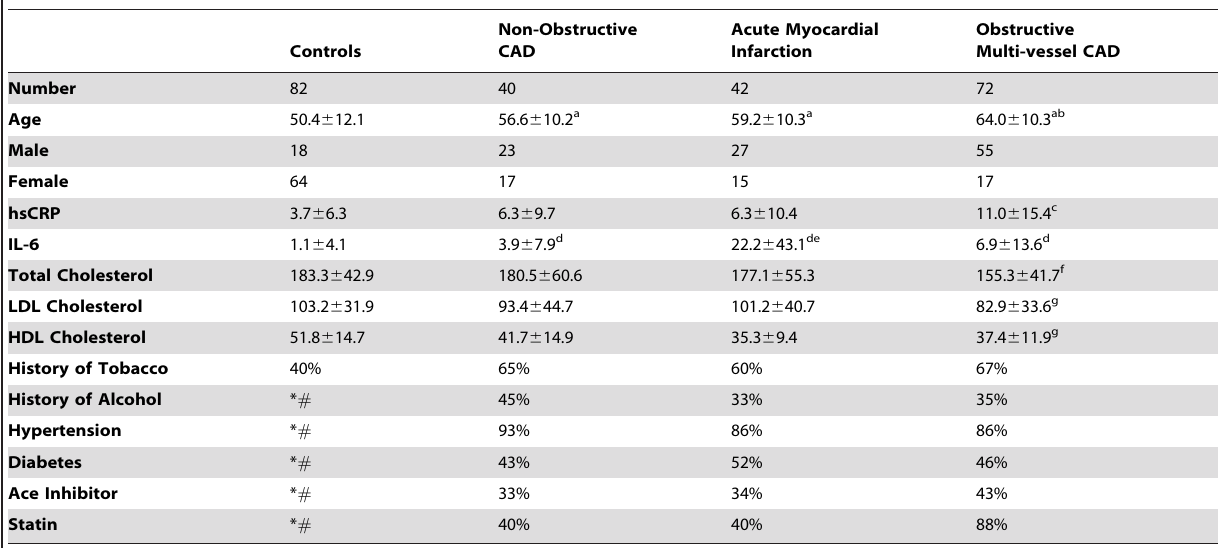
Table 1. Patient demographics.